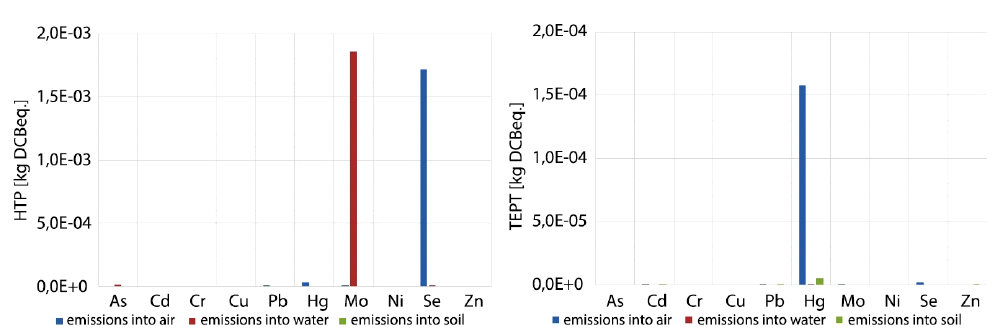
Figure 7. LCA model results – HTP (left) and TETP (right) based on the mean leaching values of selected heavymetals from ash from